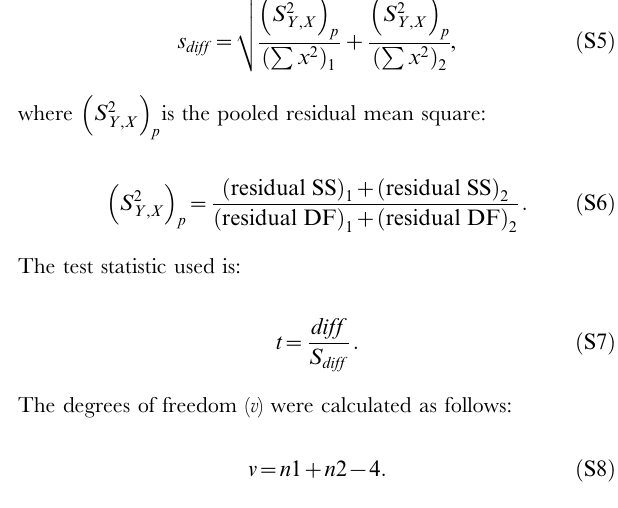
Figure S3 To rule out possible other effects of probenecid than inhibiting Panx1, we investigated the presence of organic anion transporters (OATs) in the retina. The only other proteins known to be inhibited by probenecid are OATs [67]. OAT1 is expressed in the brain [68], but retinal expression in fish has not been assessed. To test whether this transporter is also expressed in the retina, we performed an in situ hybridization (ISH) experiment.